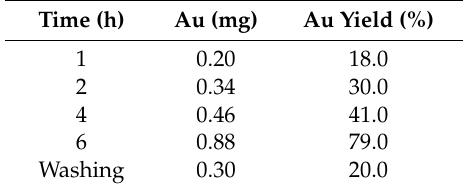
Table 6. Kinetics of Au desorption at different concentrations of carbon in